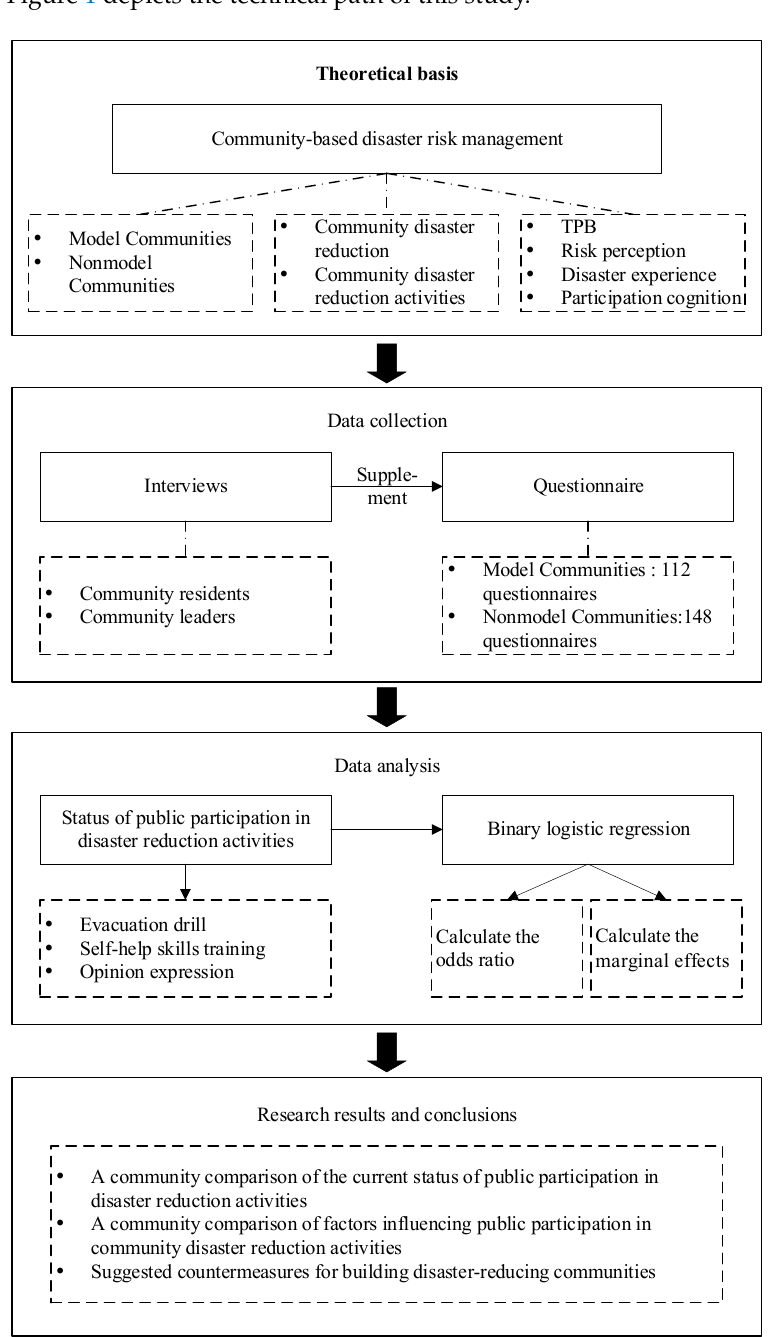
Figure 1. Technology road-mapping. The data for the model communities are from the Mulin community, and the data for the nonmodel communities are from Desheng Village, Sha’er Township, Shangengzi Village, and Danzhamu